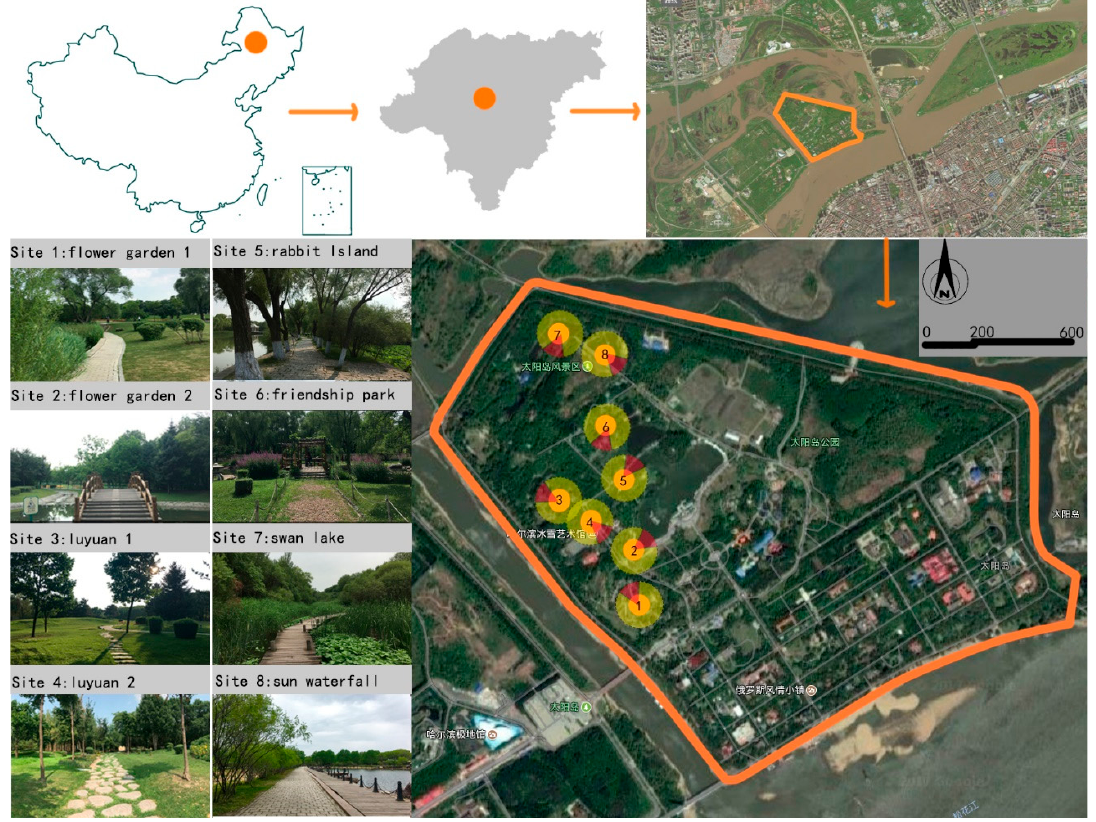
Figure 1. Map and aerial photos of the study area, site selection photographs, and plan view of Harbin Sun Island